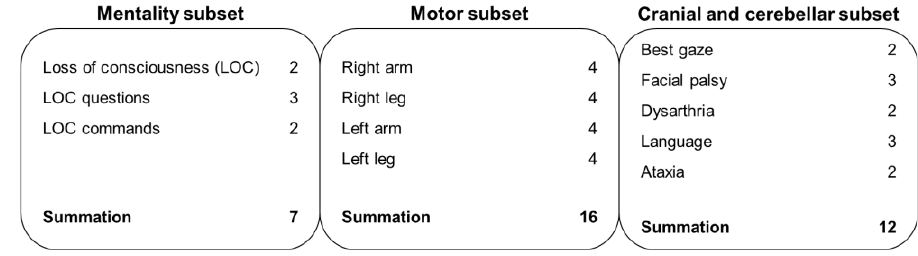
Figure 2. Classification of the NIHSS subsets for mental status, motor, and cranial and cerebellar scores.